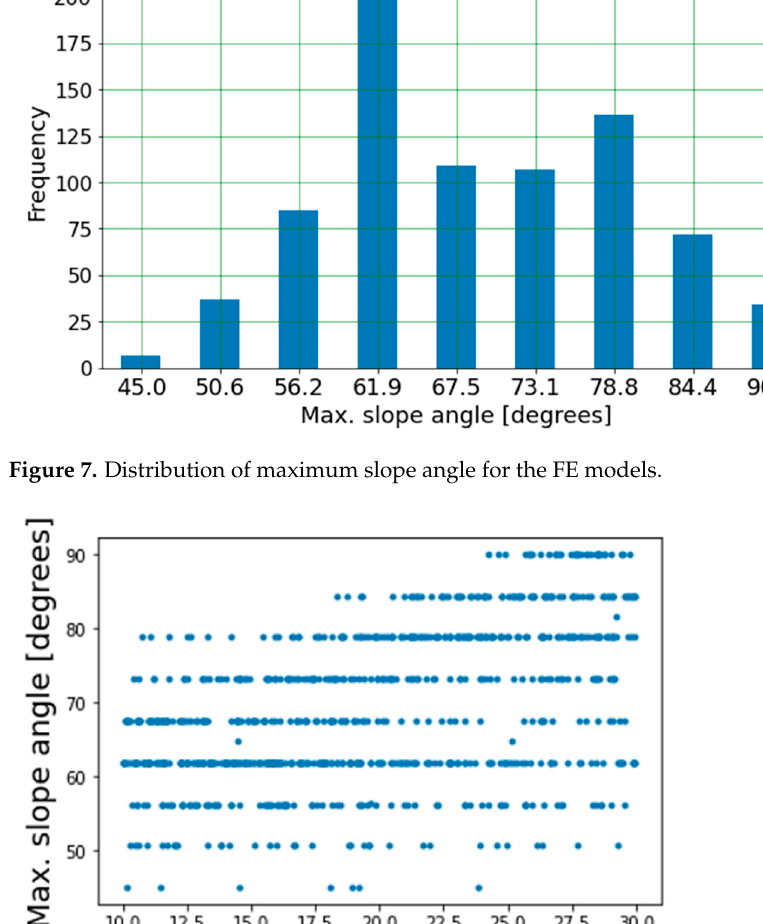
Figure 8. Plot of peak GSI vs. max. slope angle.